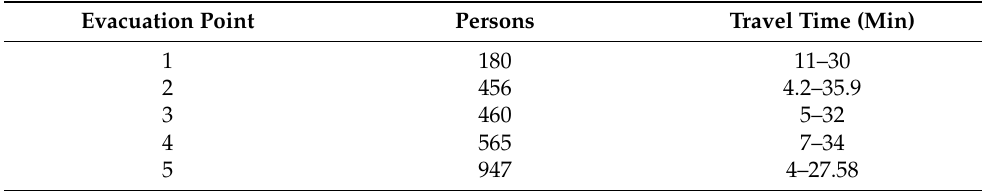
Table 5. Capacity of evacuation points in Marginea